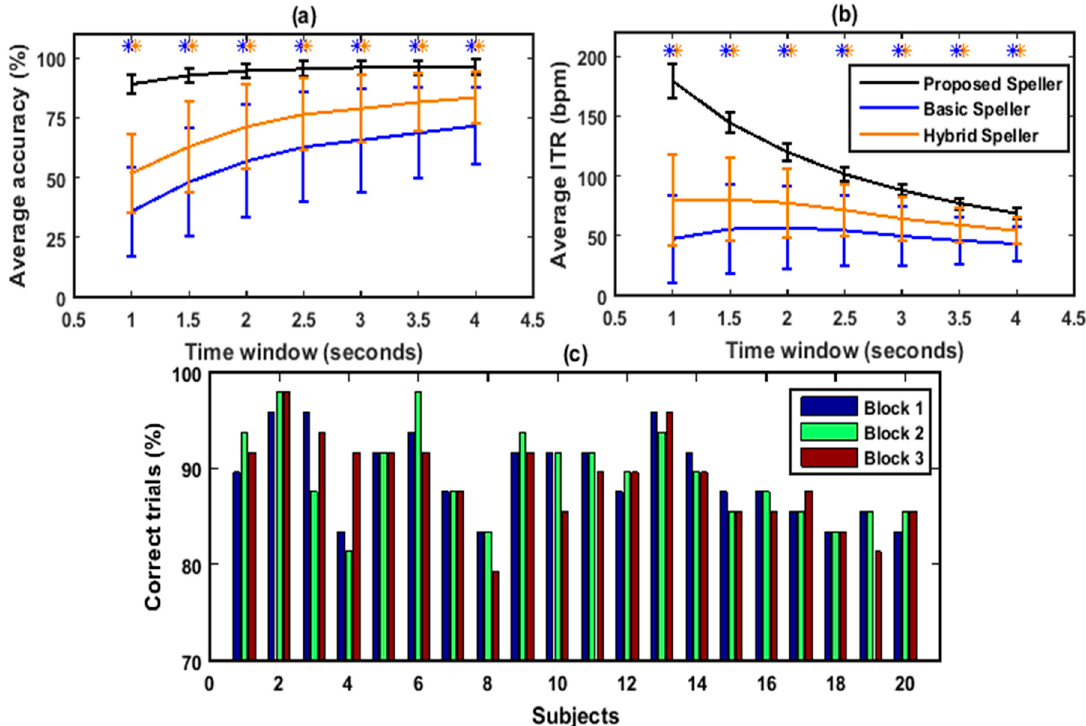
Figure 2. Performance comparison and evaluation of the proposed speller, the basic steady-state visually evoked potential brain–computer interface (SSVEP BCI)-speller, and the hybrid electroencephalography (EEG)-eye tracking-based speller for all subjects with different time windows during the offline experiment: proposed speller (black line), basic speller (blue line) and hybrid speller (orange line). ( a ) Average classification accuracies, ( b ) average information transfer rate (ITR), and ( c ) percentage of correct trials identified in each block for each subject. In ( a , b ), error bars indicate standard deviation. The asterisks indicate a significantly improved performance by the proposed speller (* p < 0.001). Table 2. Classification accuracy and information transfer rate of proposed framework with 1 s epoch lengths in o ffl ine Table 1. Results from the questionnaires.